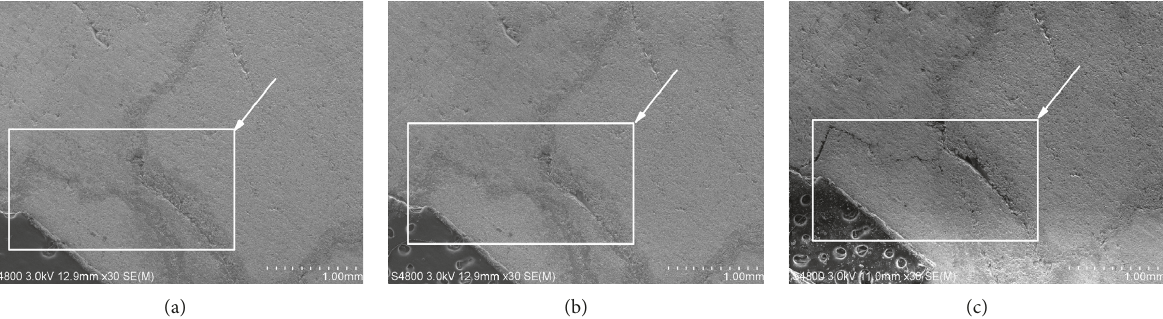
Figure 12: Crack evolution process. (a) 0min. (b) 2min. (c) 4min.